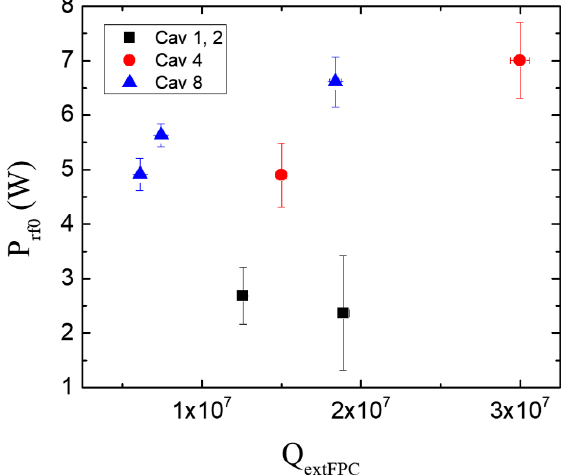
FIG. 16. The rf heat load at 2.07 K, 7 MV = m, and ϕ ¼ 0 °, as a function of Q for cavities measured in C50 CM 1L13. extFPC Cavities 1 and 2 are prototype C75 cavities installed in 1L13.